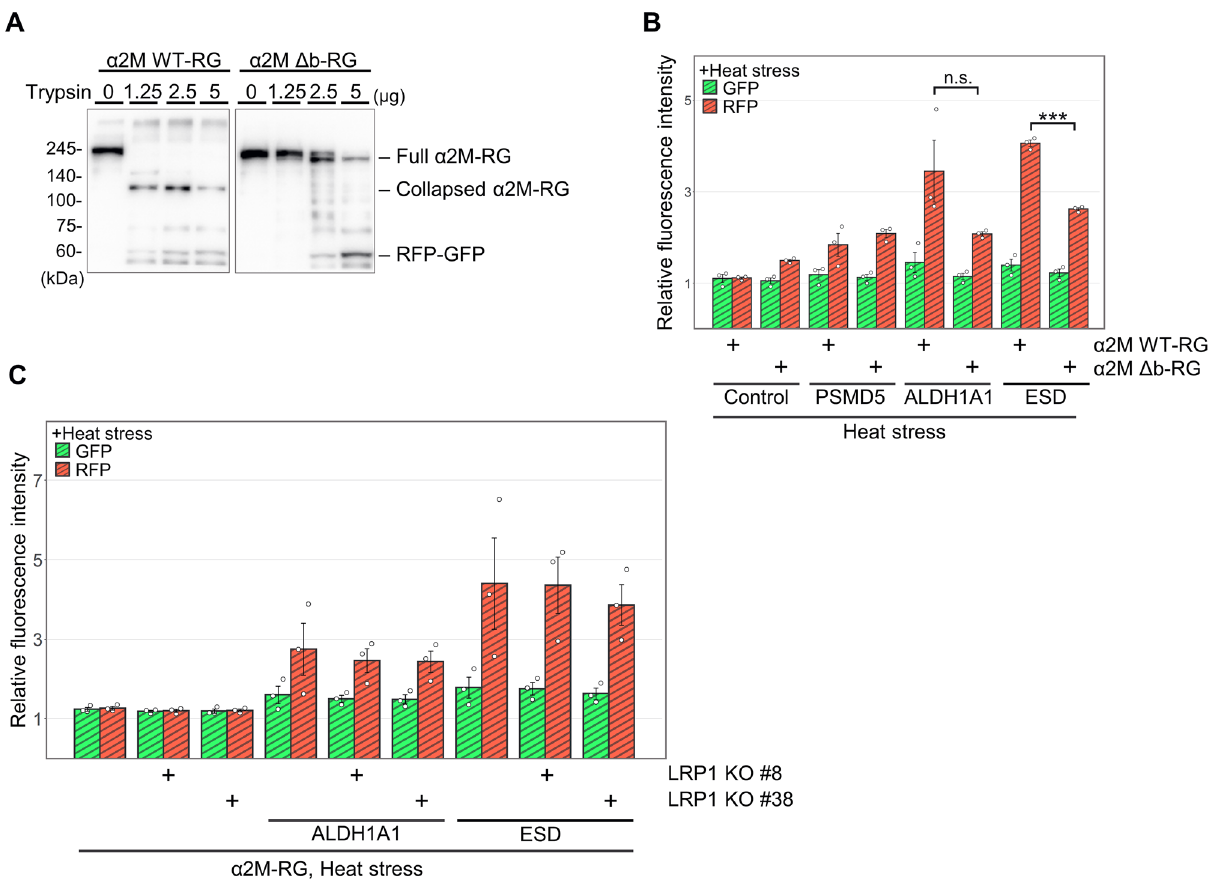
Figure 4. The bait region of α 2 M promotes lysosomal degradation. ( A ) The bait region of α 2 M Δb–RG is not cleaved by trypsin. Recombinant α 2 M WT–RG or α 2 M Δb–RG was treated with trypsin at 4 °C for 30 min, then analyzed by immunoblotting using anti-GFP. ( B ) α 2 M Δb–RG and α 2 M WT–RG internalization assays with substrates. Mixtures of substrate (PSMD5, ALDH1A1, or ESD) and α 2 M–RG (WT or Δb) were heat-shocked in serum-free medium at 50 °C for 1 h. HeLa cells were cultured in medium for 17 h at 37 °C, then analyzed using flow cytometry. Bar graph shows the relative fluorescence intensities of GFP and RFP in cells normalized to those intensities in untreated cells (n = 3). Data are means ± SEMs. n.s., not significant; *** P < 0.005 (two- tailed Student’s t -test). Small circles indicate each data point. ( C ) α 2 M–RG internalization assay with LRP1 KO cells. Substrate (ALDH1A1 or ESD) and α 2 M–RG were heat-shocked in serum-free medium at 50 °C for 1 h. HeLa WT and LRP1 KO cells were cultured in medium for 17 h at 37 °C, then analyzed using flow cytometry. Bar graph shows the relative fluorescence intensities of GFP and RFP in cells normalized to those intensities in untreated cells (n = 3). Data are means ± SEMs. n.s., not significant; *** P < 0.005 (two-tailed Student’s t -test). Small circles indicate each data point. KO, knockout; WT, wild